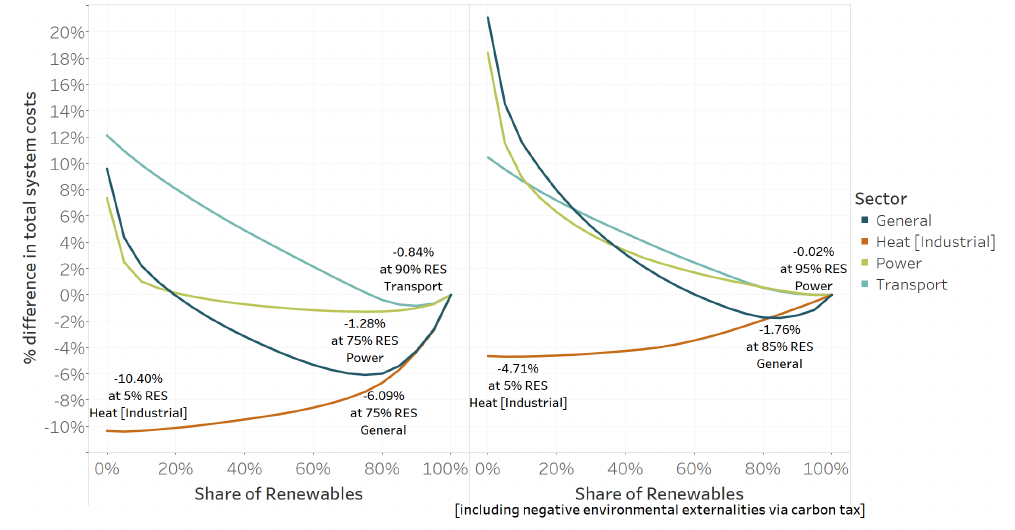
Figure 11. Relative cost difference of different levels of renewable integration (Baseline: 100%